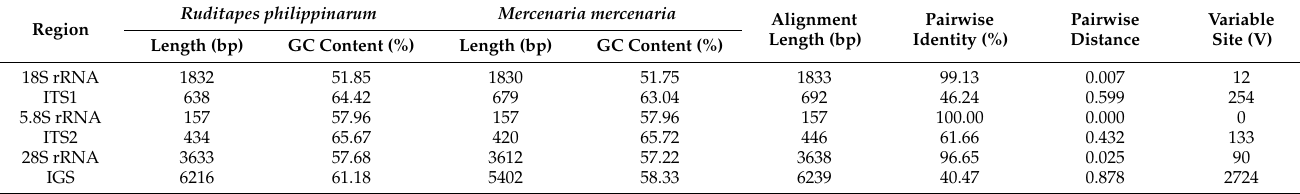
Table 3. Characterisation of rDNA from R. philippinarum and M. mercenaria